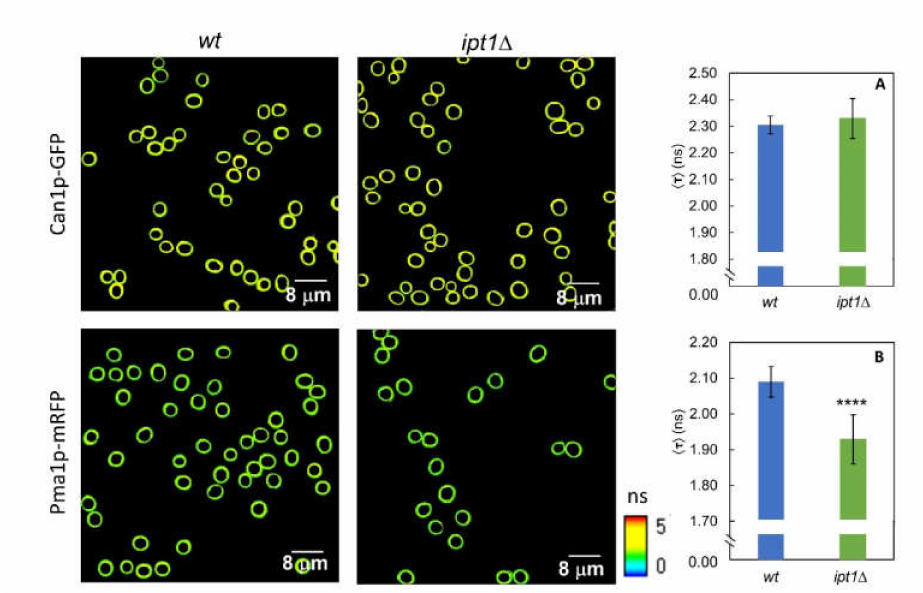
Figure 5. The lack in M(IP) 2 C leads to a change in the microenvironment surrounding Pma1p but not Can1p. Representative FLIM images of ROI comprising S. cerevisiae wt cells and ipt1 ∆ cells plasma membrane. Intensity-weighted mean fluorescence lifetime for S. cerevisiae cells. ( A ) wt -Can1p-GFP and ipt1 ∆ -Can1p-GFP cells and ( B ) wt -Pma1p-mRFP and ipt1 ∆ Pma1p-mRFP cells. The values are the mean ± S.D. of three independent biological replicates with a total of ca. 400 cells analyzed for each strain. **** p ≤